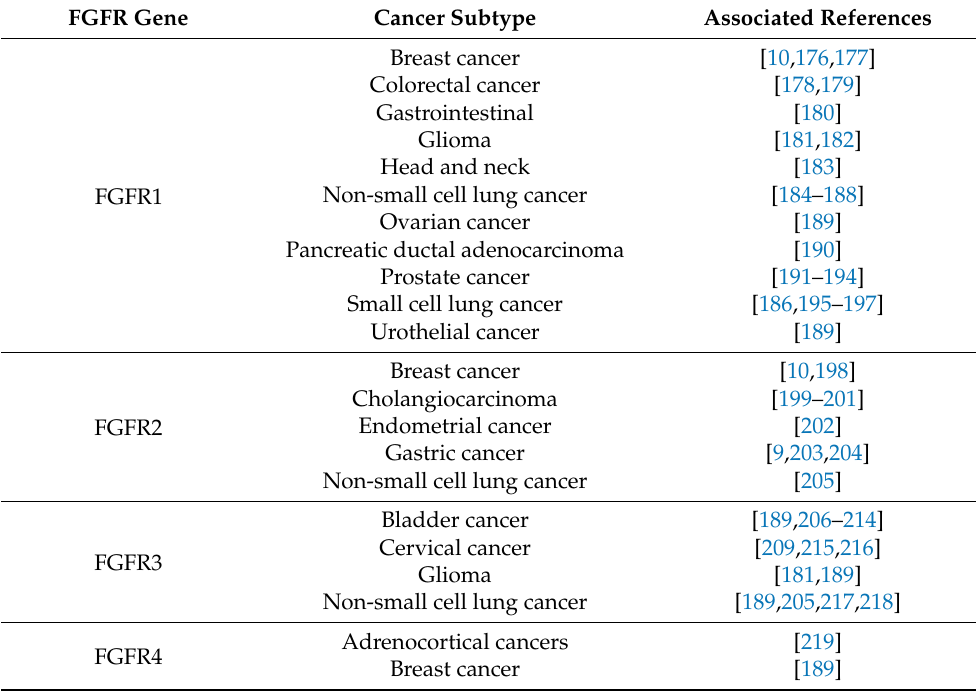
Table 2. Examples of cancer subtypes for which Fibroblast Growth Factor Receptor (FGFR) genetic aberrations have been